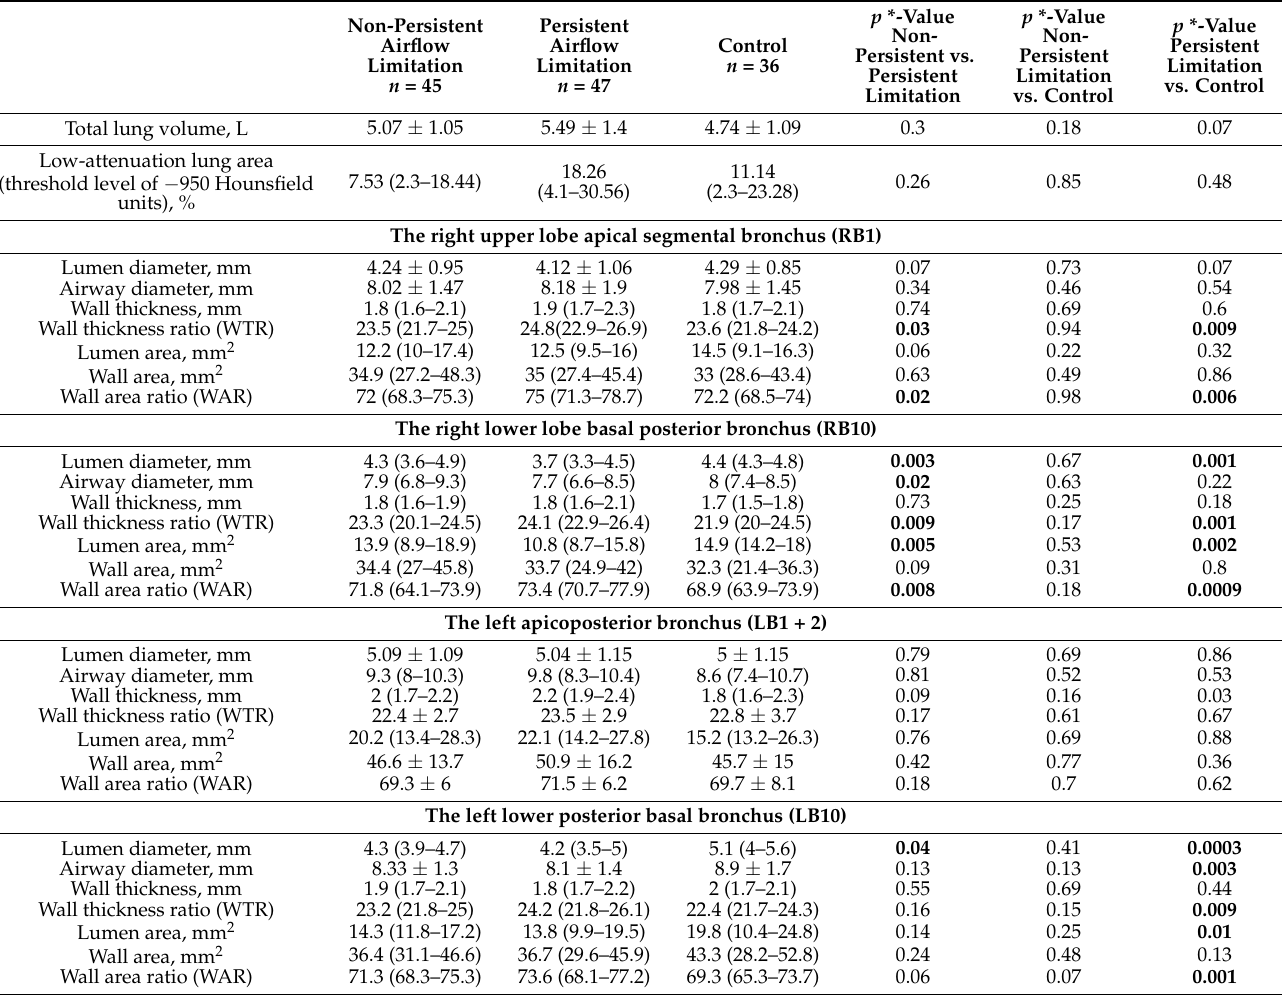
Table 4. Indices of lung computed tomography airway